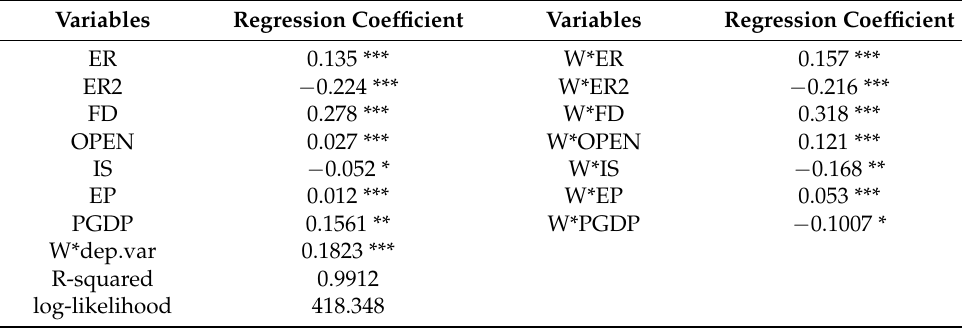
Table 7. Spatial panel Durbin model regression